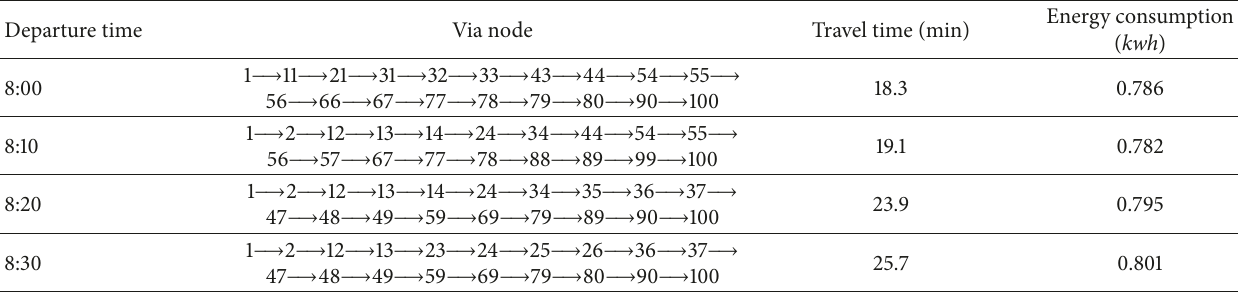
Table 9: The shortest routes from node 1 to node 100 at different departure time (in Scenario 4).